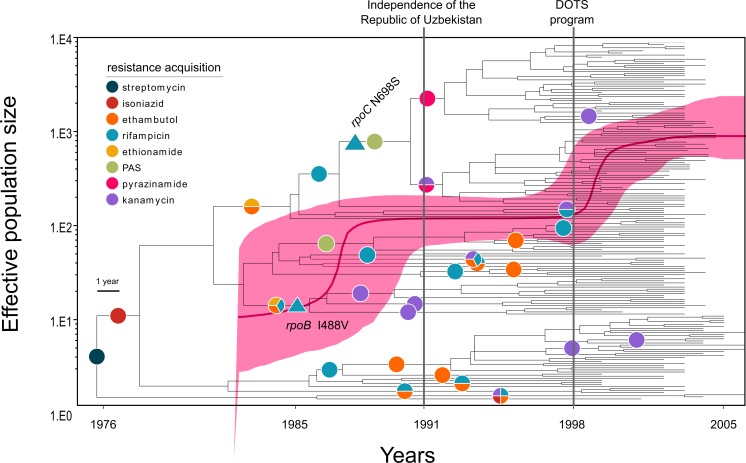
Evolutionary history of MTBC Central Asian outbreak (CAO) strains.Genealogical tree of CAO strains in Karakalpakstan, Uzbekistan and effective population size over time based on a (piecewise-constant) Bayesian skyline approach using the GTR substitution model and a strict molecular clock prior of 0.94 × 10−7 substitutions per nucleotide per year. Pink shaded area represents changes in the effective population size giving the 95% highest posterior density (HPD) interval with the pink line representing the mean value. Vertical lines indicate time points of the implementation of the first standardized TB treatment program (DOTS) in Karakalpakstan and of the declaration of Uzbekistan as independent republic. Symbols on branches show steps of fixation of resistance conferring mutations.